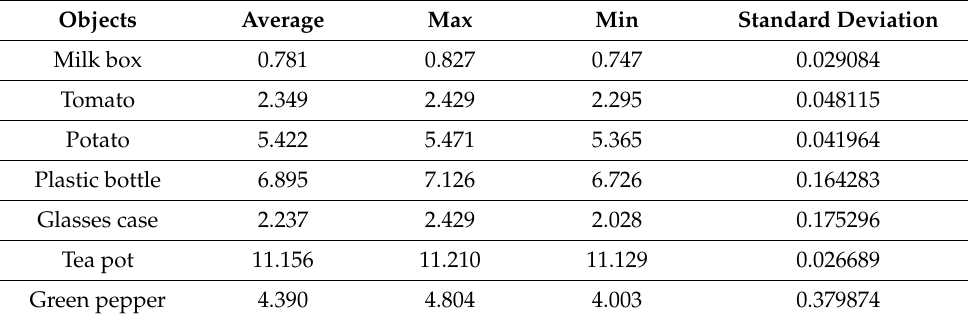
Table 3. Comparison of grasping force results